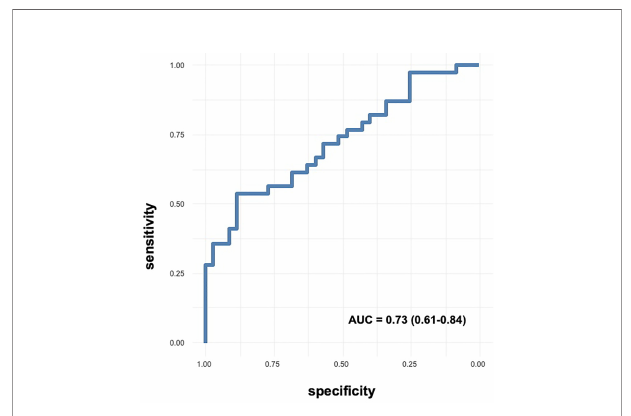
FIGURE 2 | ROC curves of ACE2 expression in predicting short stature. Accuracy of ACE2 expression as predictor of